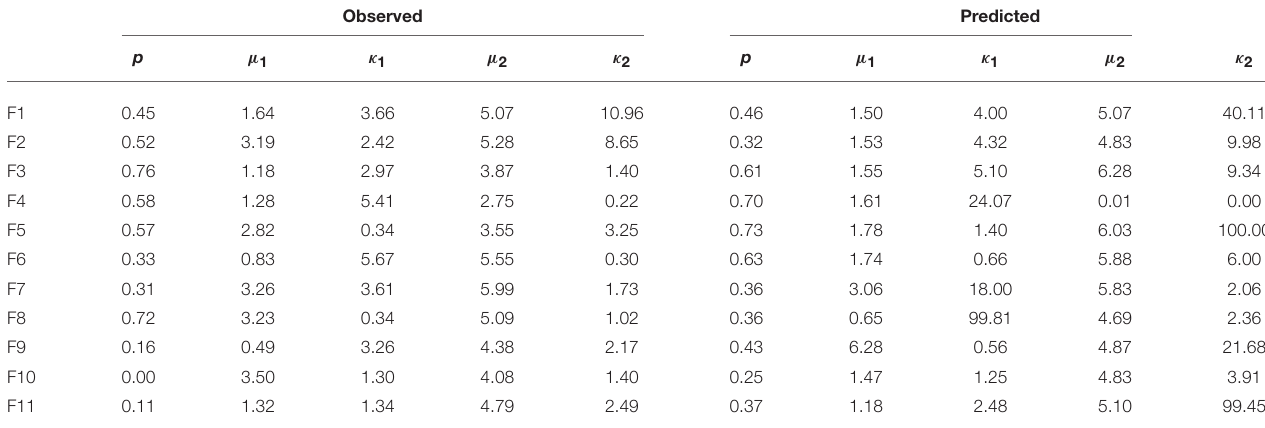
TABLE 6 | Estimated parameters for a 2-component mixture von Mises model fit to the observed and predicted wind direction distributions across Flea Creek